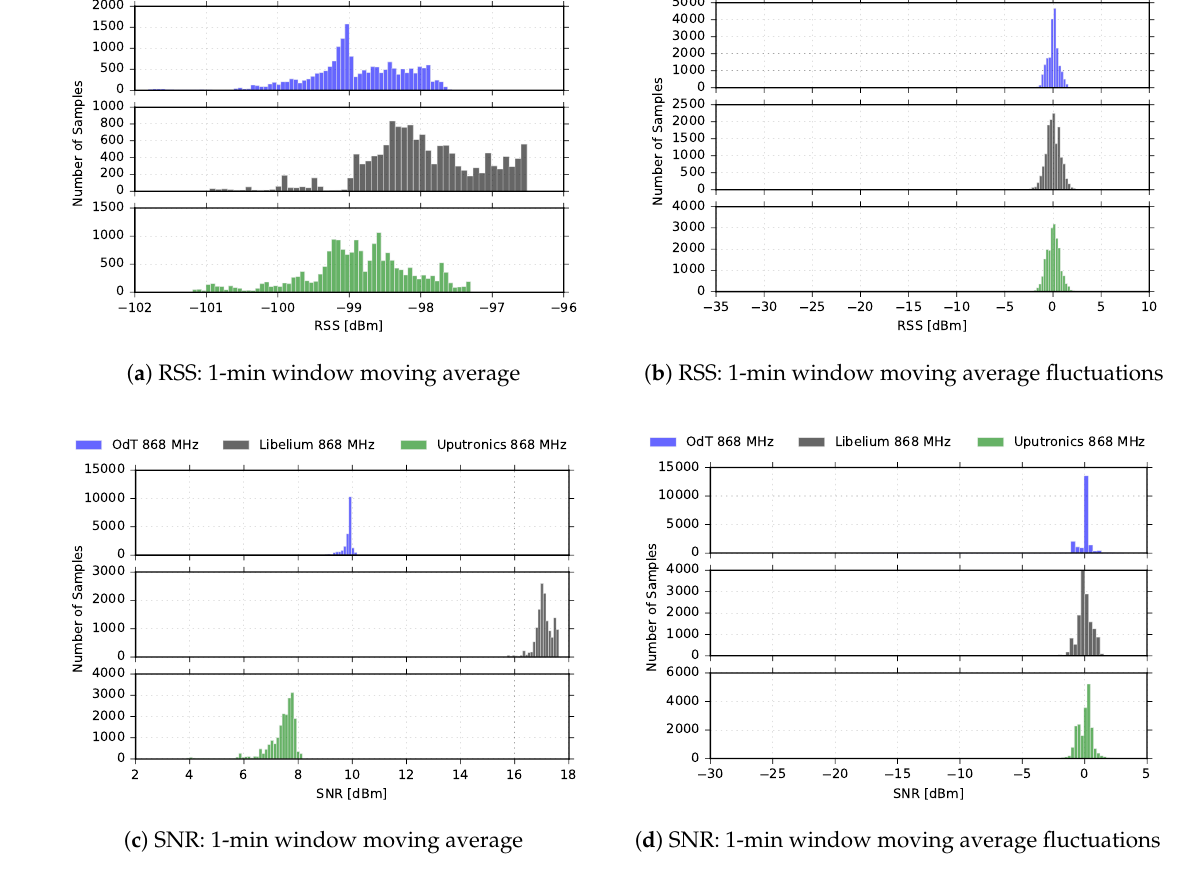
Figure 10. RSS and SNR histograms for ODT, Uputronics and Libelium: f = 868MHz, BW = 125kHz, SF = 7, CR = 4/6,